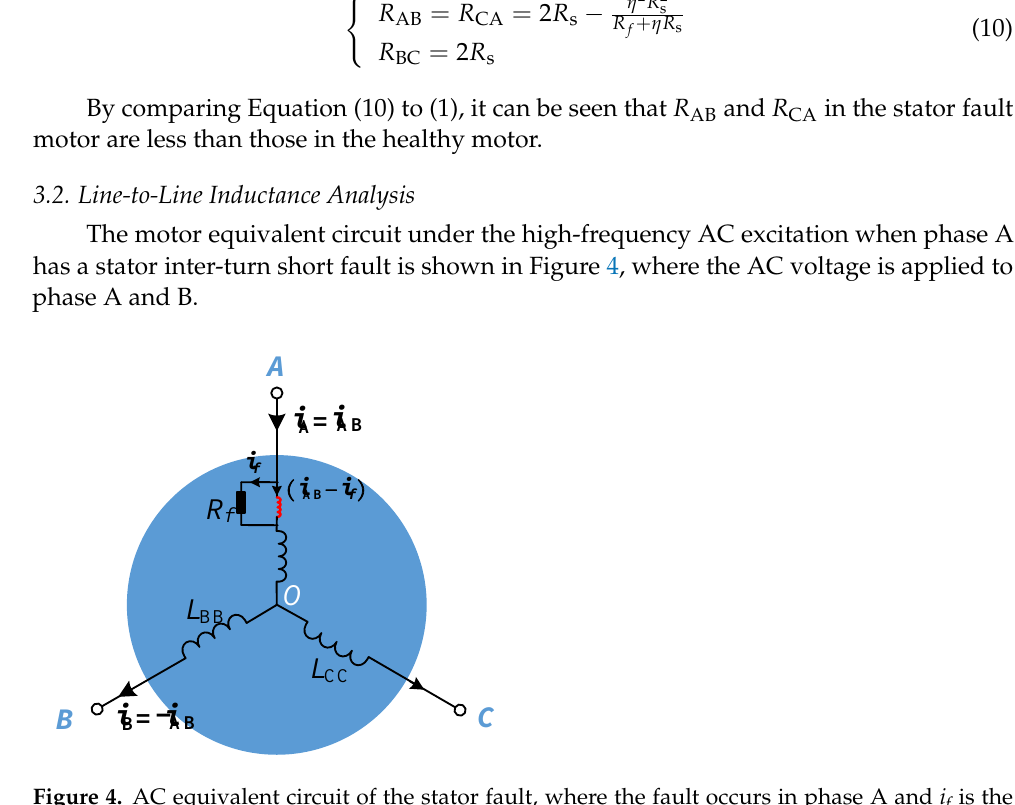
Figure 4. AC equivalent circuit of the stator fault, where the fault occurs in phase A and i f is the current that flows through the fault